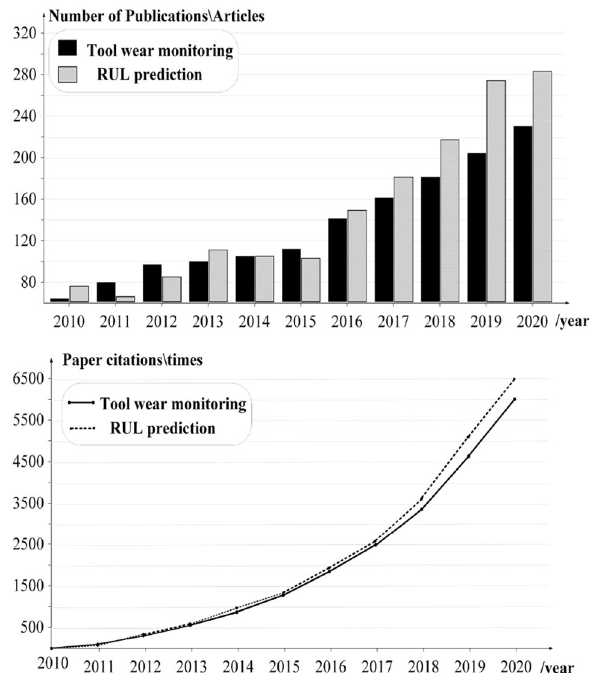
Fig. 1 The research trend of tool